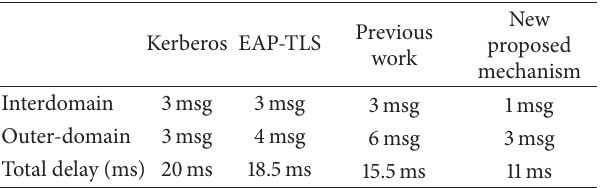
Table 6: Computing the delay in interdomain and outer-domain in the three authentication mechanisms.